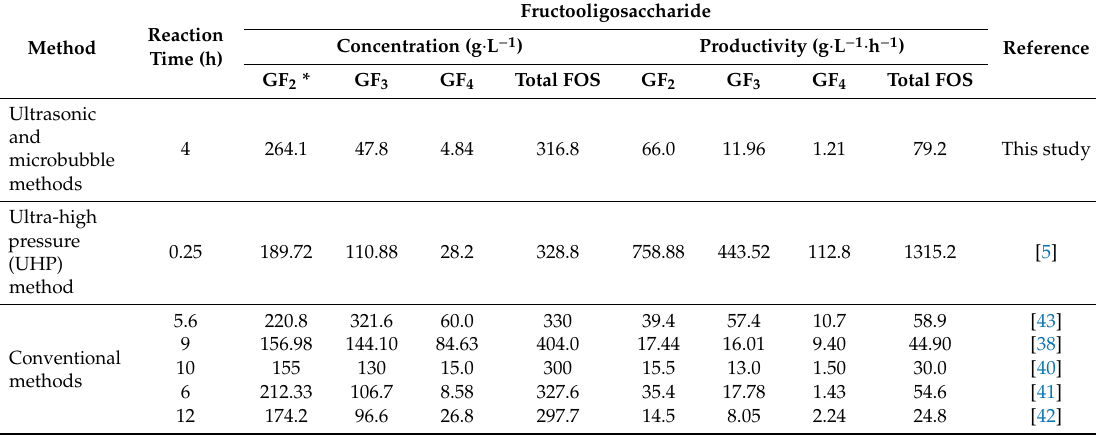
Table 6. Fructooligosaccharide (FOS) yield and productivity obtained from this study compared to other